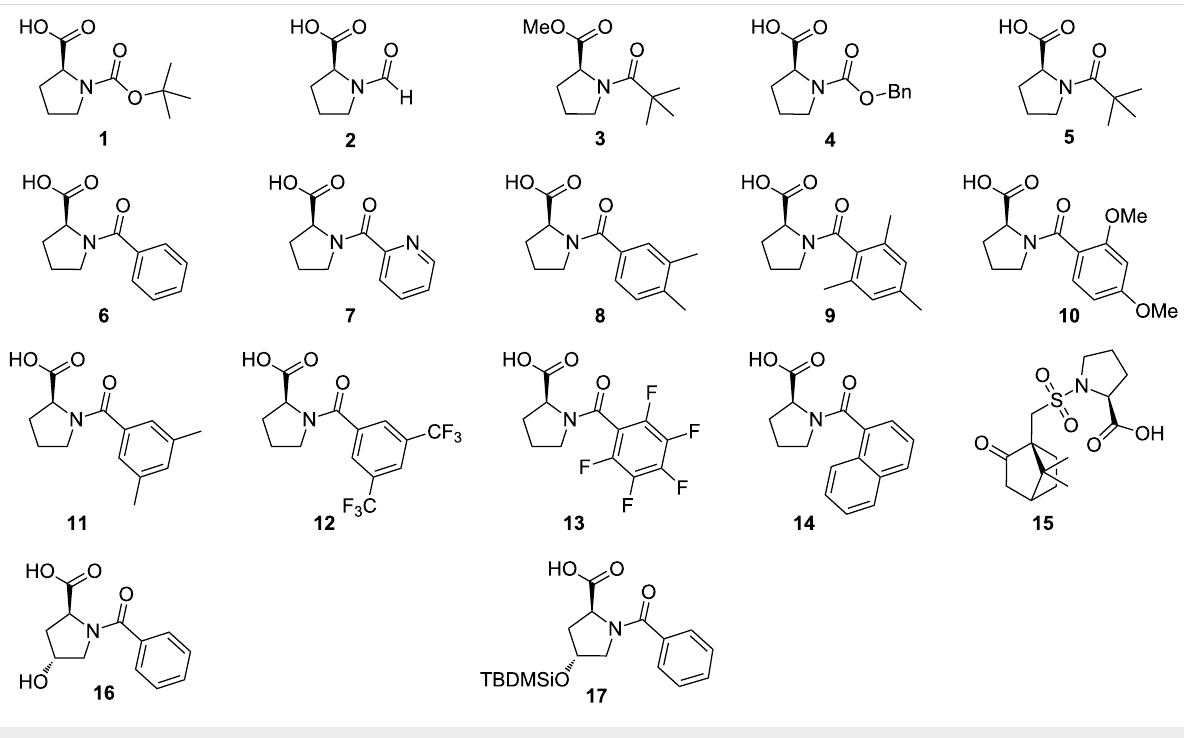
Figure 4: Catalysts synthesized and studied in this work.